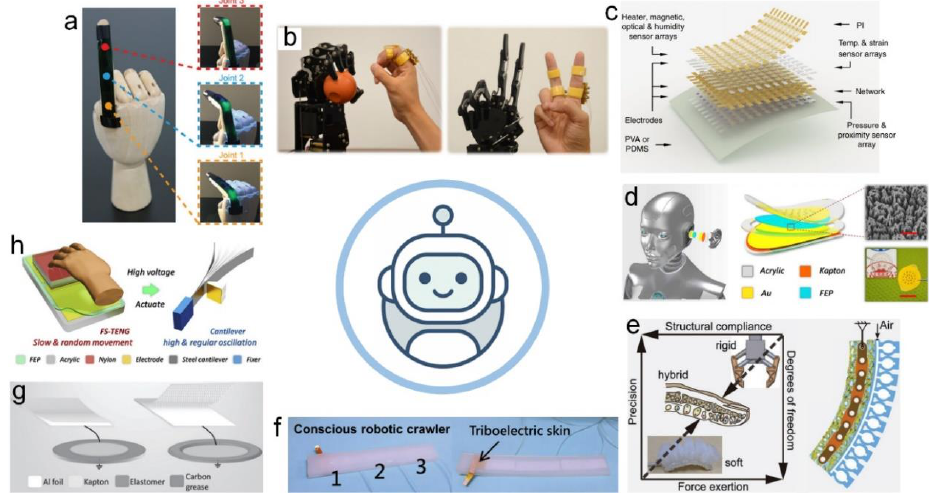
Figure 21. TENGs for robotics applications. ( a ) Stretchable triboelectric–photonic smart skin for tactile and gesture sensing. Reproduced with permission [207]. Copyright 2018, John Wiley &